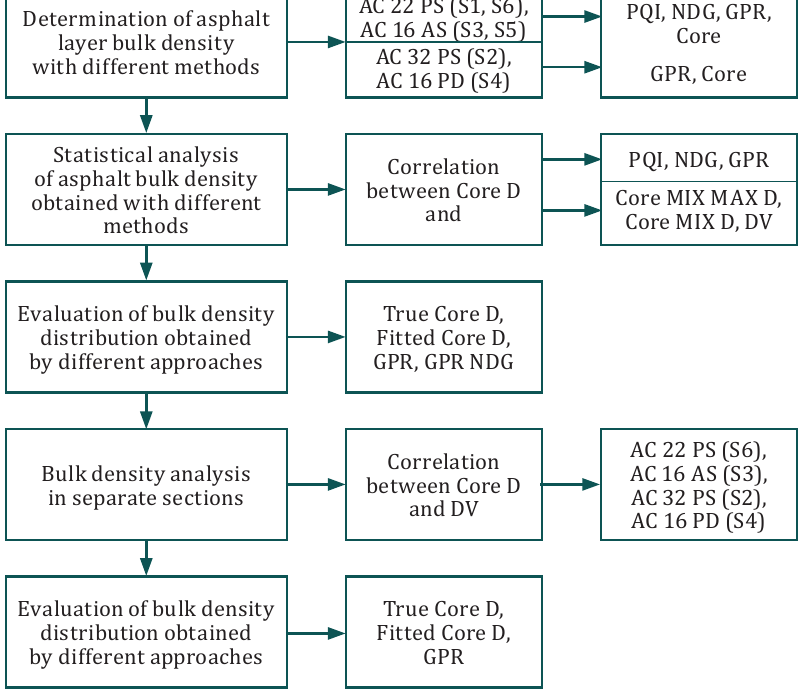
Evaluation of bulk density distribution obtained by different Figure 5. A simplified experimental plan